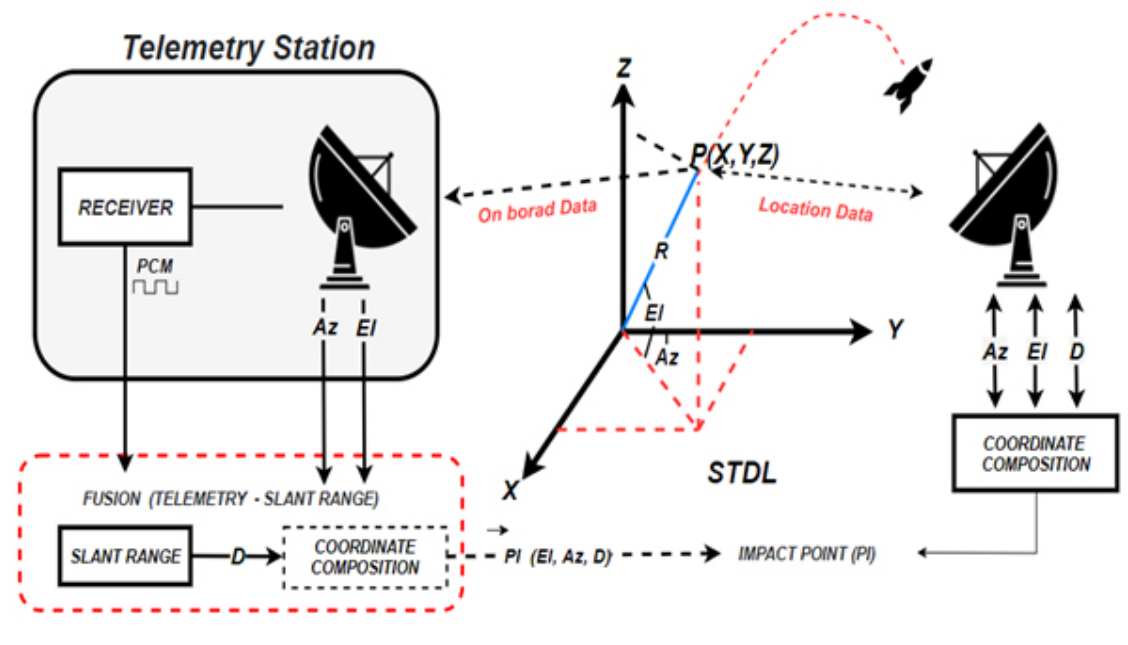
Figure 2. Illustration of obtaining the impact point.